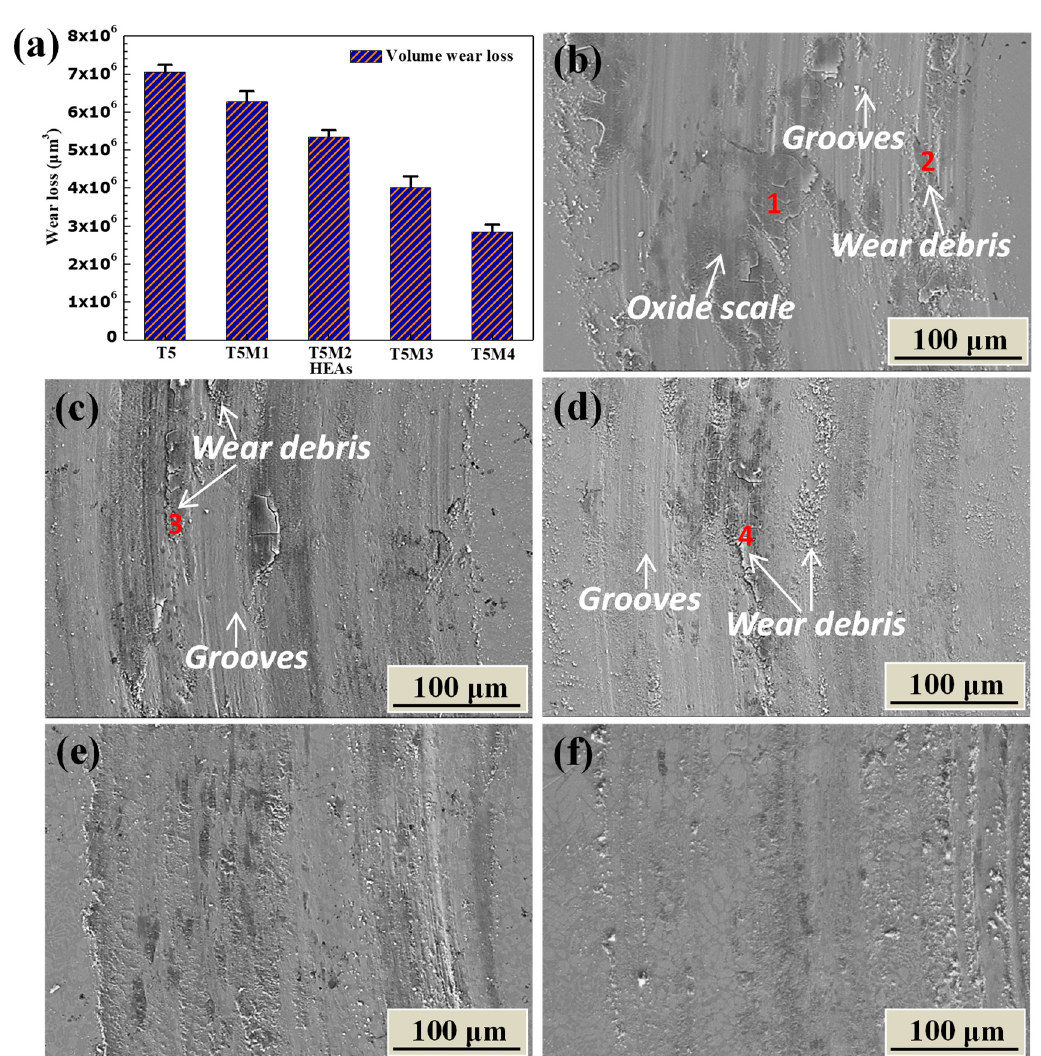
Figure 7. ( a ) Wear volume loss of AlCrFeNiTi 0.5 Mo x over a sliding distance of 45 m, and corresponding SEM micrographs of worn surfaces. ( b ) AlCrFeNiTi 0.5 , ( c ) AlCrFeNiTi 0.5 Mo 0.1 , ( d ) AlCrFeNiTi 0.5 Mo 0.2 , ( e ) AlCrFeNiTi 0.5 Mo 0.3 , and ( f ) AlCrFeNiTi 0.5 Mo 0.4 , Table 4. Chemical compositions (at. %) of different regions in worn surfaces of AlCrFeNiTi 0.5 ,